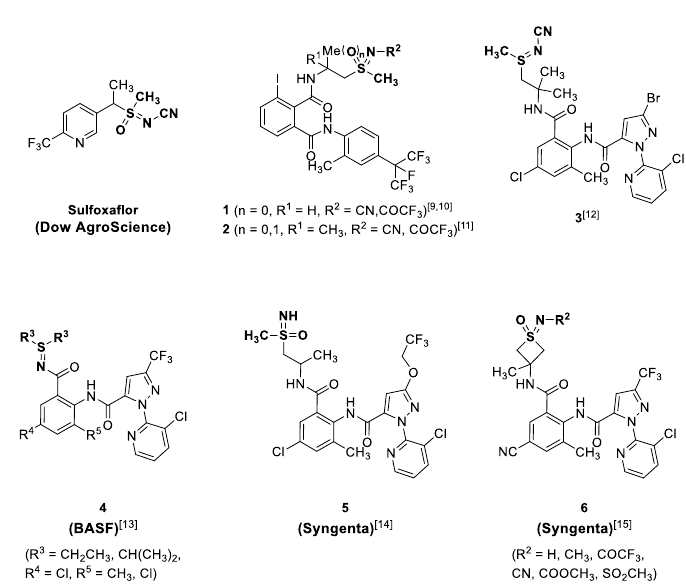
Figure 1. Examples of alkyl sulfilimine- and sulfoximine-substituted insecticides [1–15].